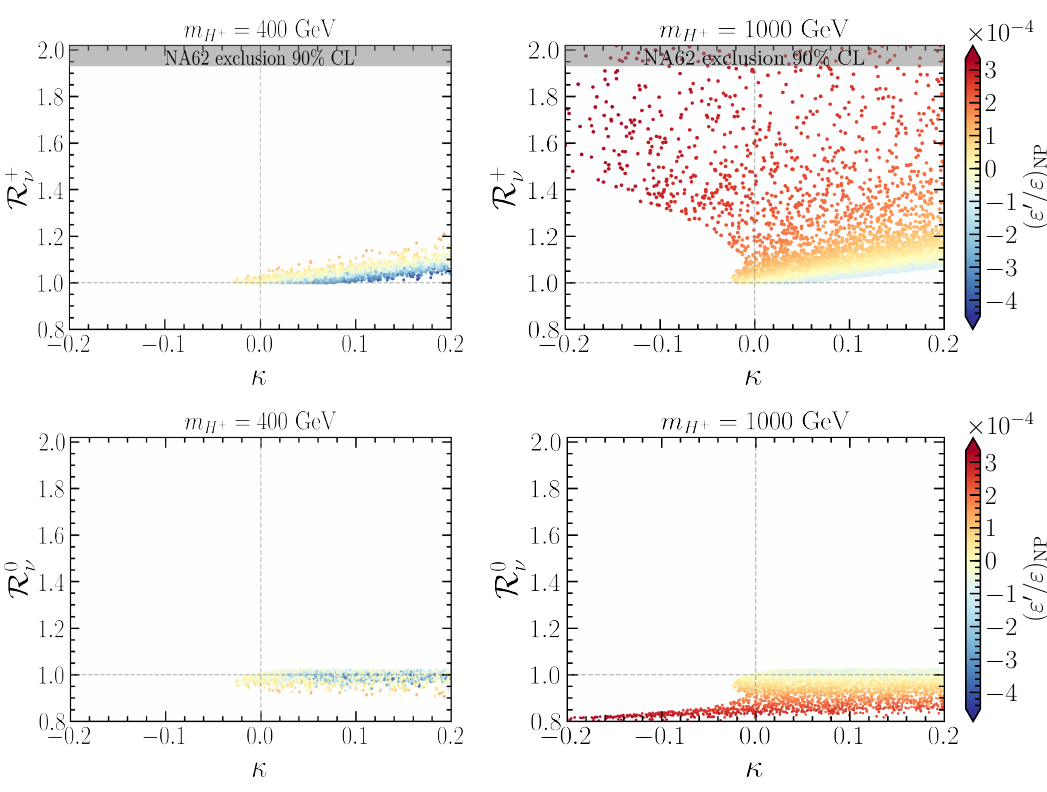
Figure 6 . Ratios R +